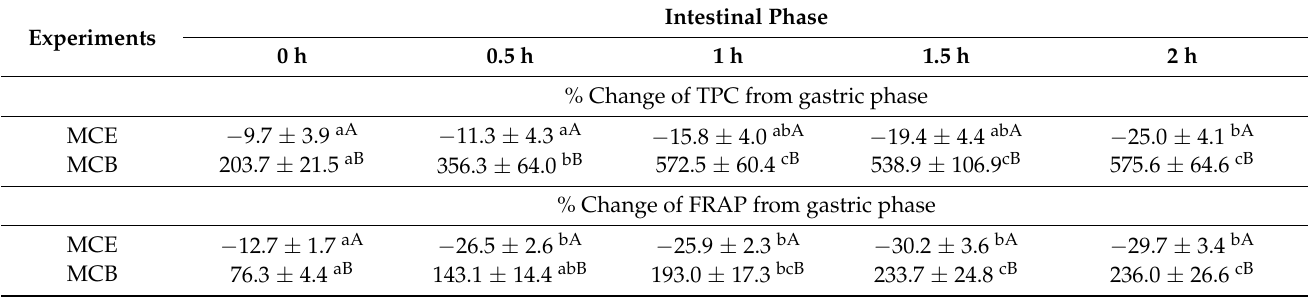
Table 2. The percentage changes of total phenolic content (TPC) and the ferric reducing antioxidant power (FRAP) during simulated